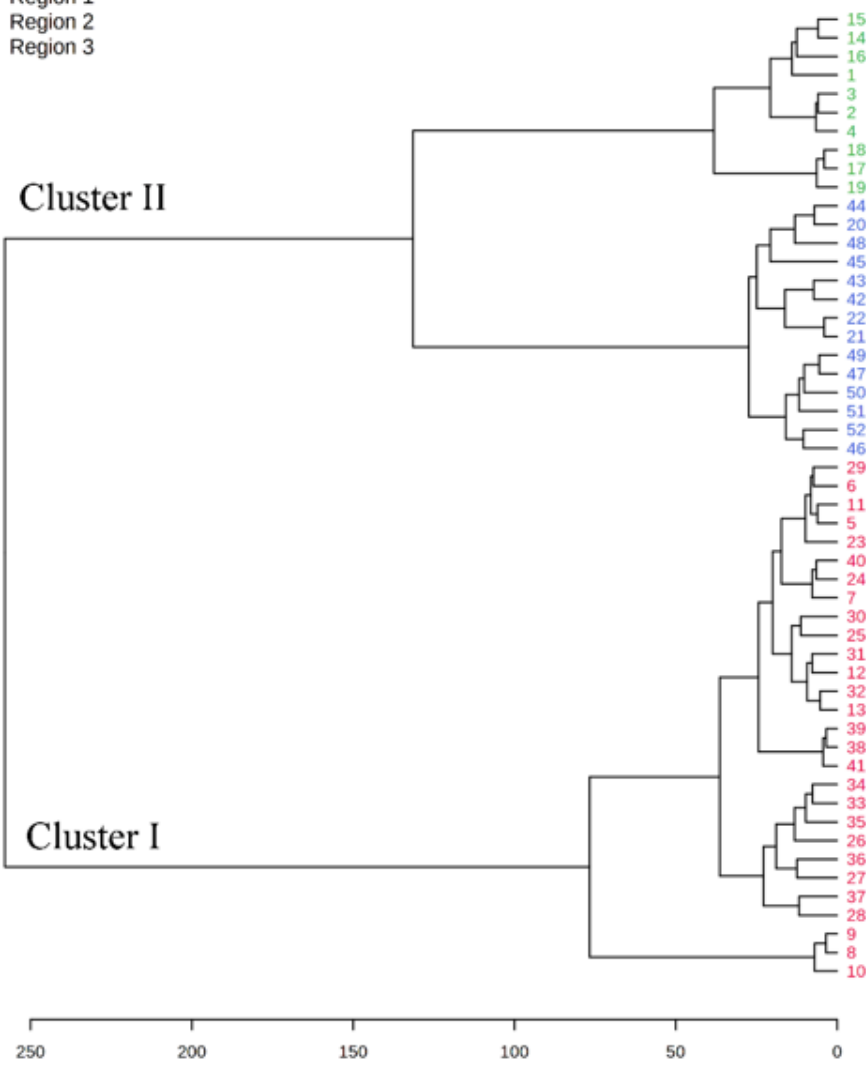
Figure 2. Dendrogram illustrating cluster analysis (distance measure and clustering algorithm were. done using Euclidean and Ward). M. champaca accessions are indicated by names according to Table 1.